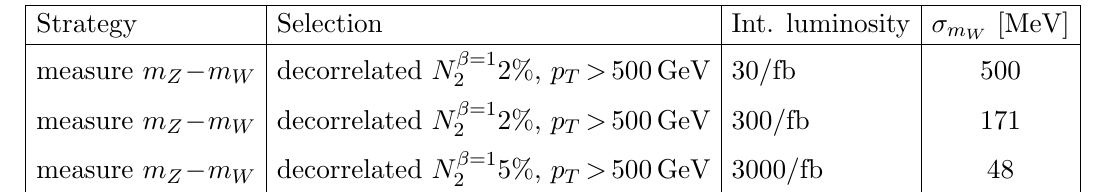
Table 2 . Statistical uncertainty of (cid:1) m = m Z (cid:0) m W mass measurement for di(cid:11)erent selections.